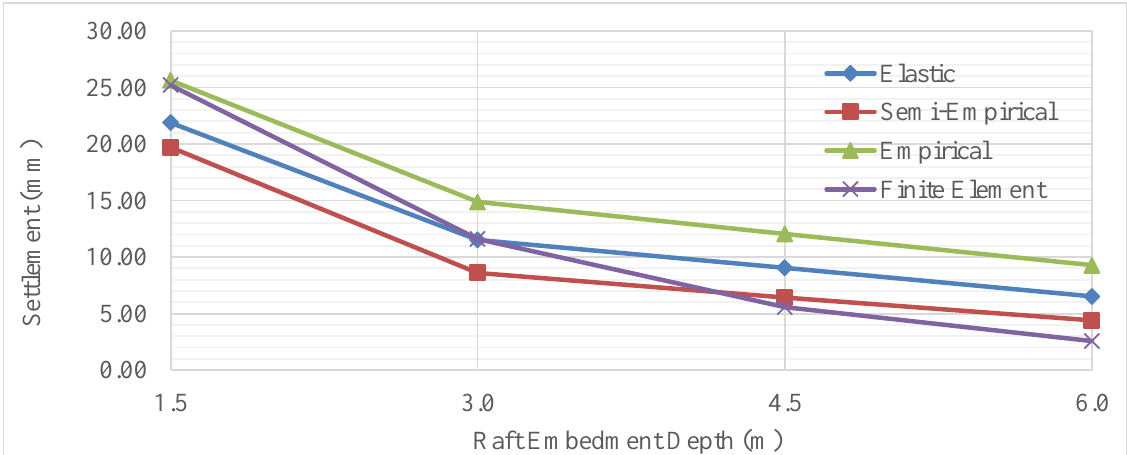
Fig. 5. Settlement versus embedment depth for 100 kN/m 2 applied pressure.